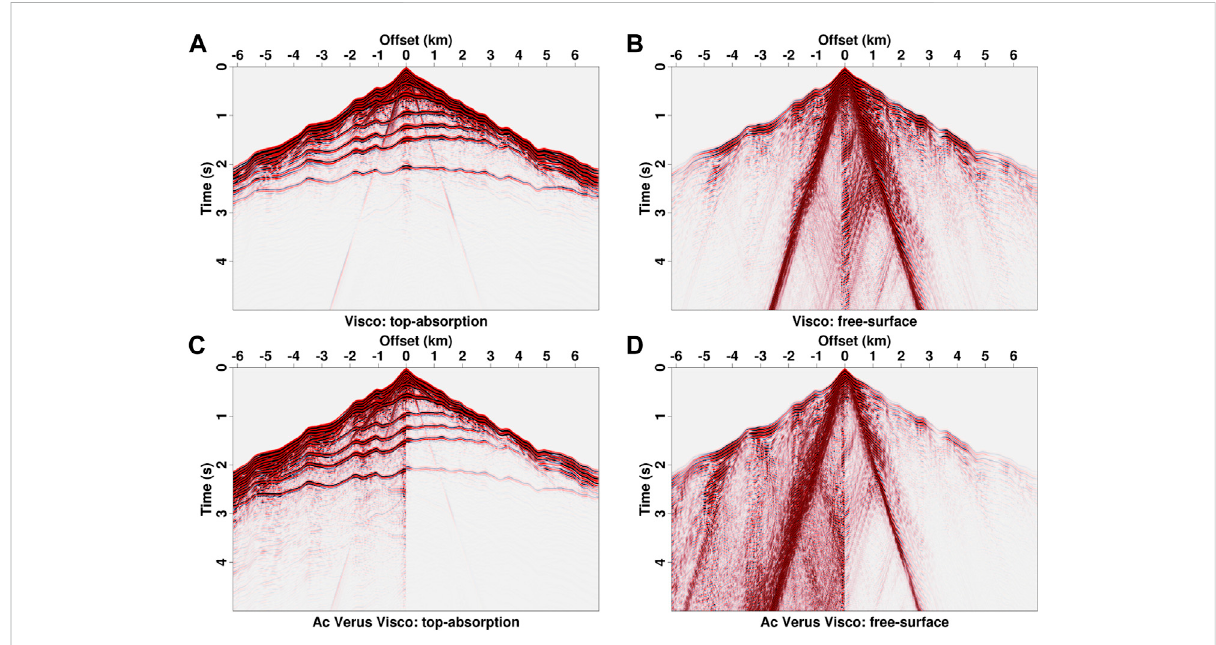
FIGURE 14 Common-shot gathers of 2D Loess Plateau model (A,B) Viscoacoustic modeling with top absorption and free surface boundaries, (C,D) comparison of acoustic (left half panel) and viscoacoustic (right half panel) records computed with top absorption and free surface